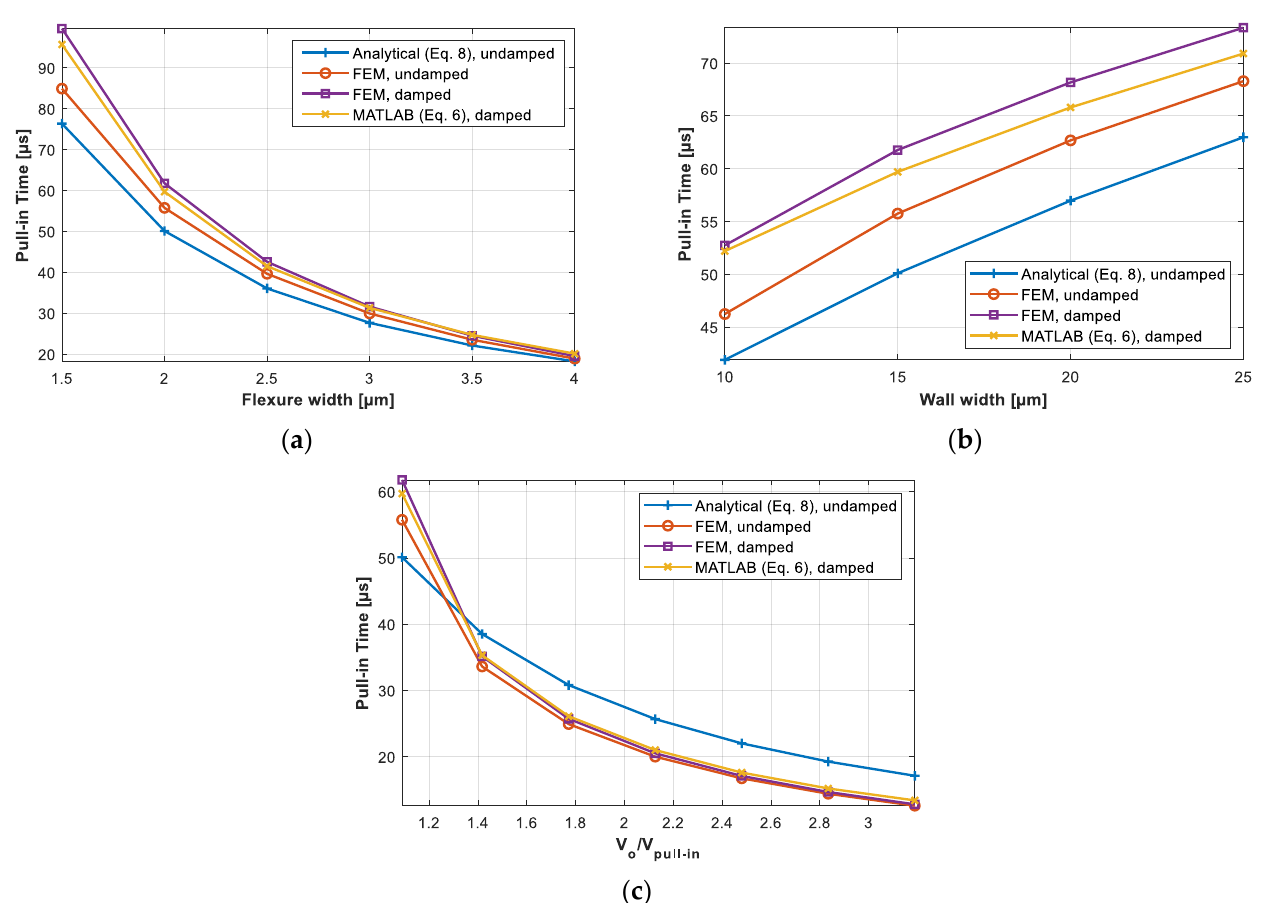
Figure 8. The results of transient parametric analyses of the pull-in time, where the latter is plotted as a function of the following: ( a ) the flexure width (by sweeping both w x and w y with the corresponding actuation voltage amplitude required for pull-in); ( b ) the wall width w w ; and ( c ) the normalized actuation voltage V 0 / V Pull - in (the analytically calculated V Pull - in ∼ = 56.4 V). In the plots, the 2D FEM results of the damped and undamped regimes are compared with the analytical solutions based on Equation (8). Additionally, the lumped-parameter model solutions by MATLAB/Simulink are also plotted.